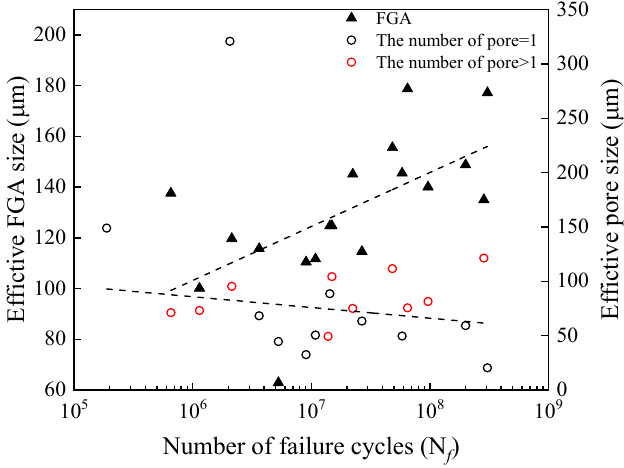
Figure 12. Relationship between the effective sizes of pores and FGA and fatigue life.